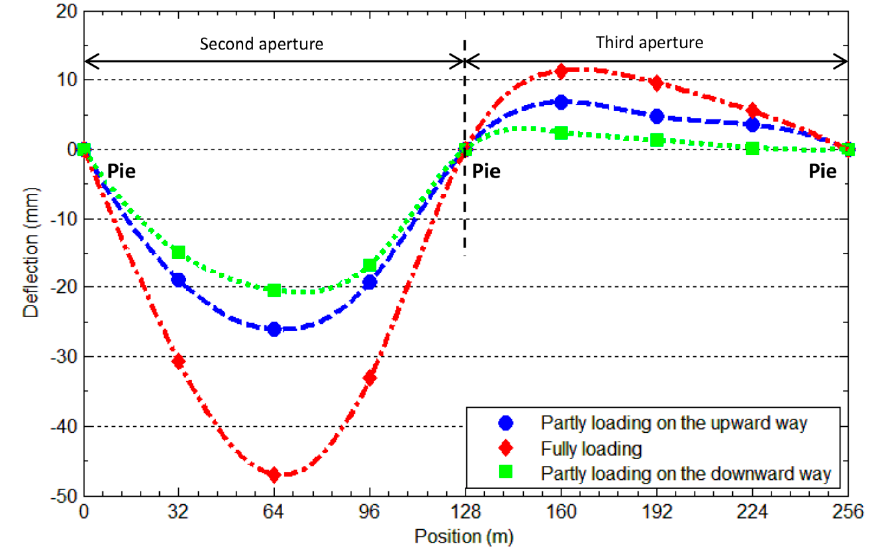
Figure 9. Measured deflection curves for the two spans under three different loading conditions.